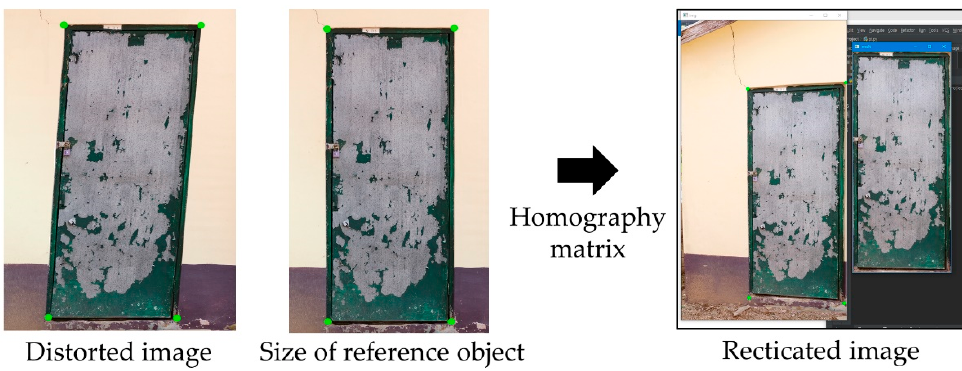
Figure 2. Image rectification using a homography matrix based on the size of the reference object.